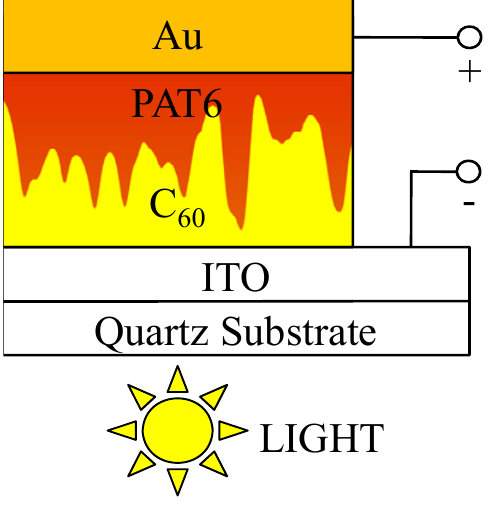
Figure 1. Typical structure of an interpenetrating heterojunction organic thin film solar